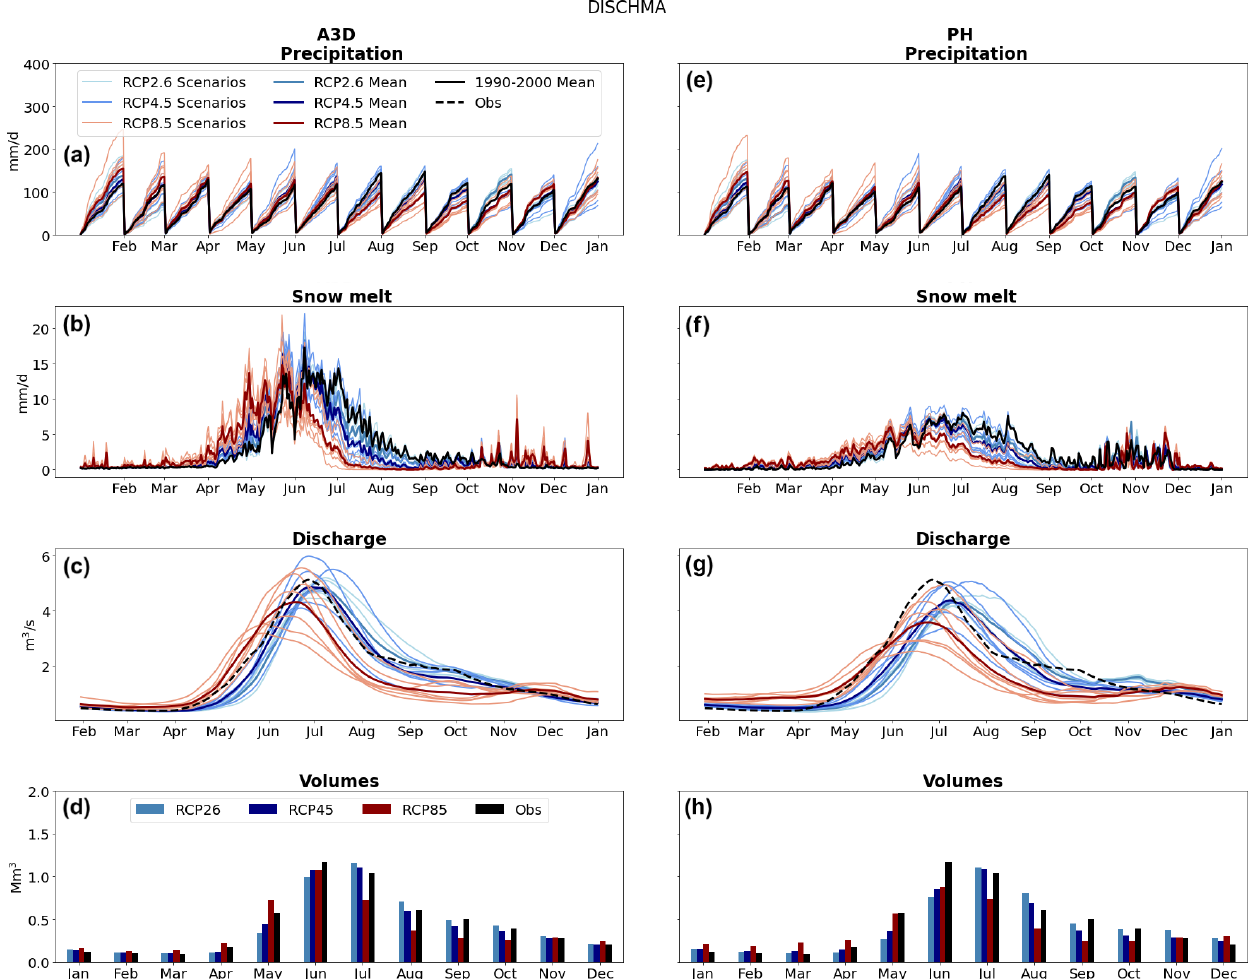
Figure 10. Climate change scenarios over the Dischma catchment for 2080–2090 against the reference mean over 1990–2000 for precipi- tation (a) , snowmelt (b) , discharge (c) and volumes (d) predicted by A3D (a–d) and PH (e–h) . Precipitation and volumes are presented as average monthly cumulates. Snowmelt is presented as the average year. Discharge is presented as the average year, smoothed by a moving average with a window of